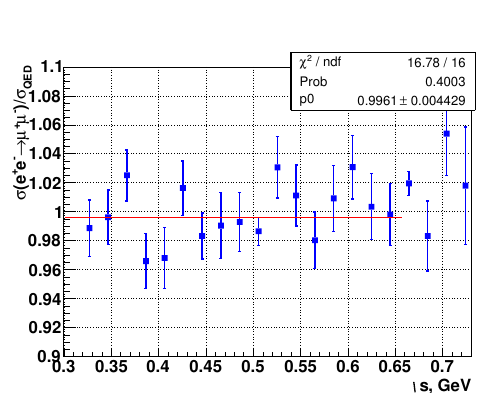
Figure 4. Preliminary results on F 2 Open crosses – separation done on the calorimeter information, filled squares – on particle momentum.